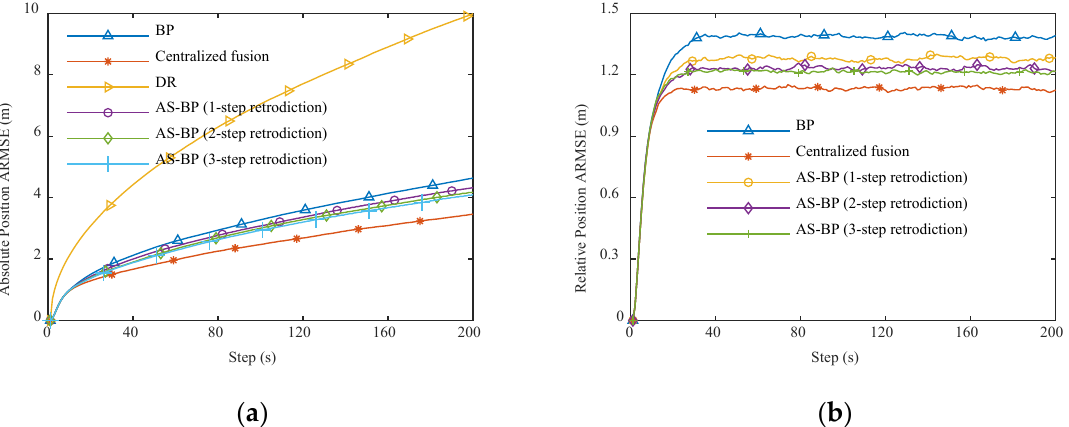
Figure 3. Absolute and relative position RMSEs in chain topology. ( a ) Absolute position RMSE. ( b ) Relative position RMSE.